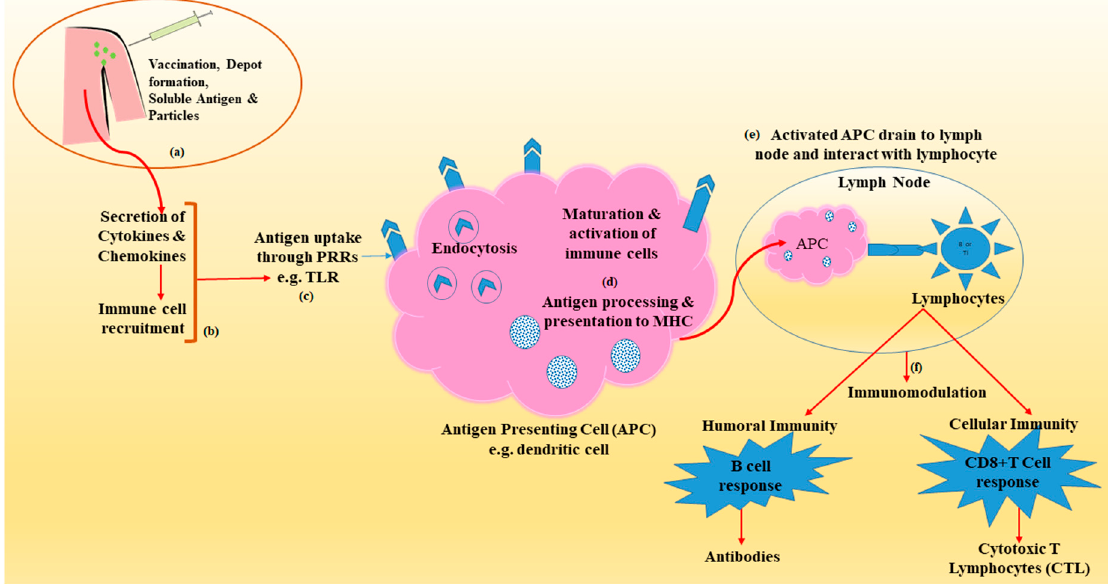
Figure 1. Representative mechanism of action of adjuvants. ( a ) After vaccination, depot formation (in some cases), release of particles and soluble antigen; ( b ) Secretion of cytokines and chemokines, which are involved in the recruitment of various immune cells at the injection site thereby formation of immunocompetent environment; ( c ) Antigen uptake through various pattern recognition receptors (PRRs), e.g. Toll-like receptor (TLR) which are expressed on surface as well as intracellularly. These PRRs are recognized and activated by the antigens and adjuvants; ( d ) Antigen uptake by antigen-presenting cells (APCs) leads to maturation and activation of immune cells and further processing for presentation to major histocompatibility complex (MHC) by upregulating the expression of MHC; ( e ) Activated APCs then migrate to draining lymph node to interact with lymphocyte; ( f ) this leads to immunomodulation by triggering humoral and cellular immunity [19,20].